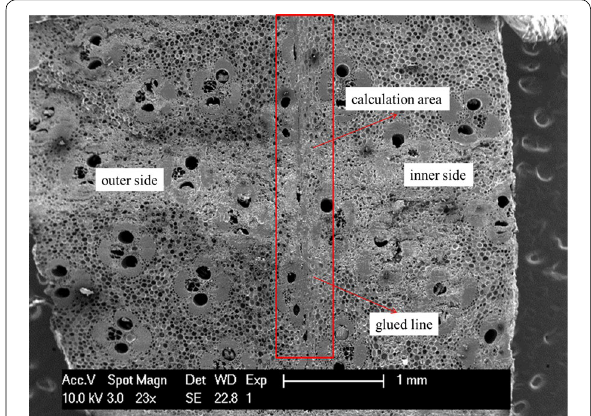
Fig. 7 Morphology of fibers and parenchymata along the glue line